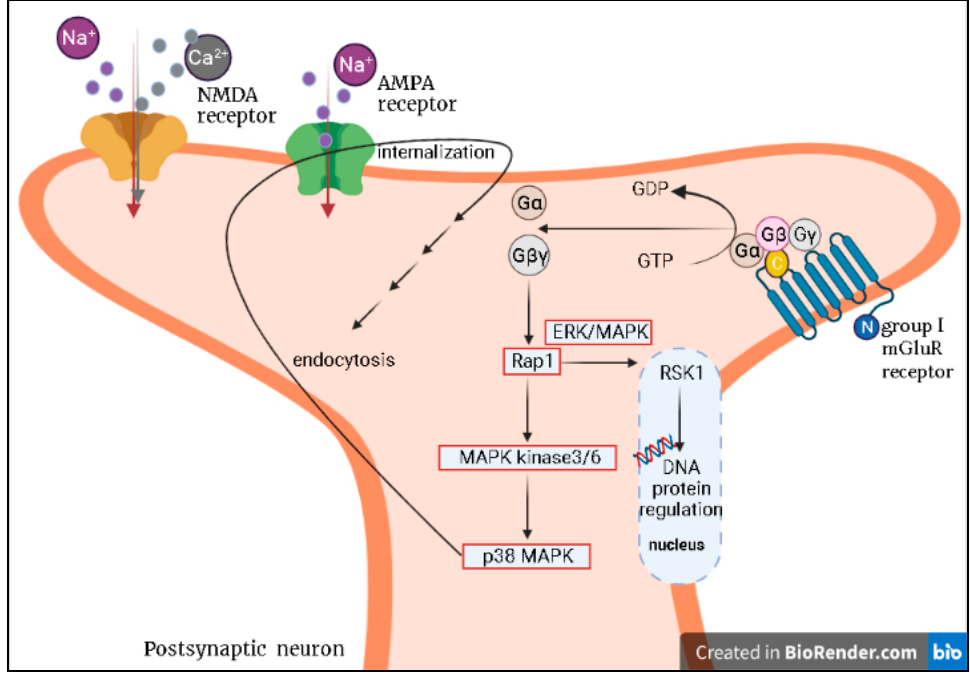
Figure 1. Signal pathway involved in mGluR–LTD. Metabotropic receptors (mGluRs) are G protein-coupled receptors. G proteins are activated when GTP is converted to GDP, and the three subunits ( α , β , and γ ) are dissociated. The release of G β and γ subunits activates Rap 1 and MAPK kinase 3/6. Subsequently, P38 MAPK, after it is activated, promotes AMPA receptor internalization and endocytosis. Additionally, the Rap 1–MAPK/ERK pathway activates nuclear protein RSK1. MAPK: mitogen-activated protein kinases; ERK: extracellular signal-regulated kinases; RSK1: ribosomal S6 kinase-1.